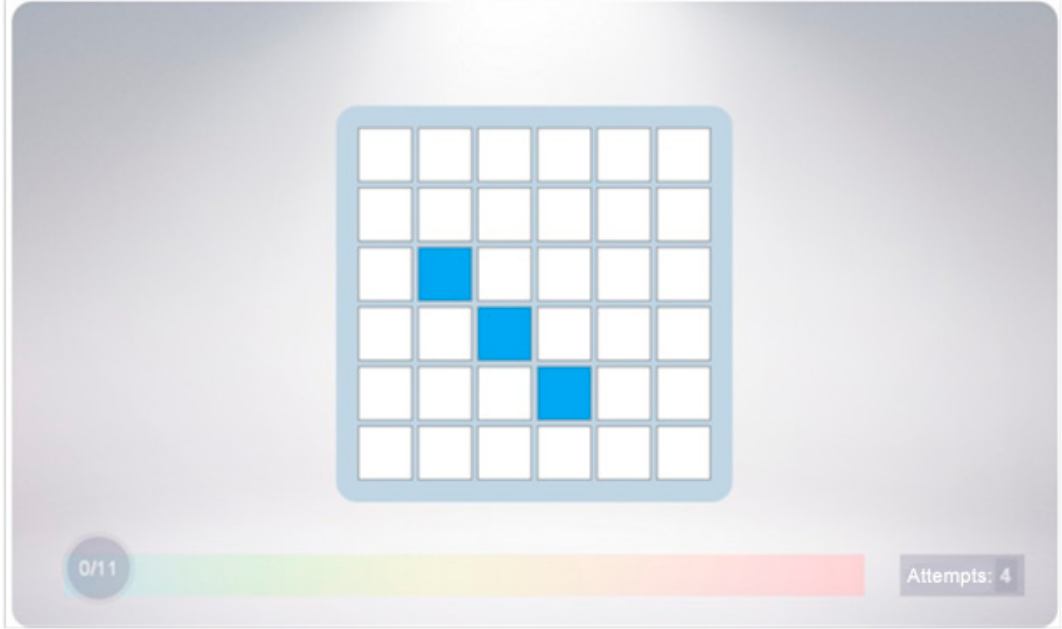
Figure 3. An example stimuli configuration with 3 squares that compose 3 von Neumann figures or 1 Moore figure (a screenshot from the software that we used in the experiment).